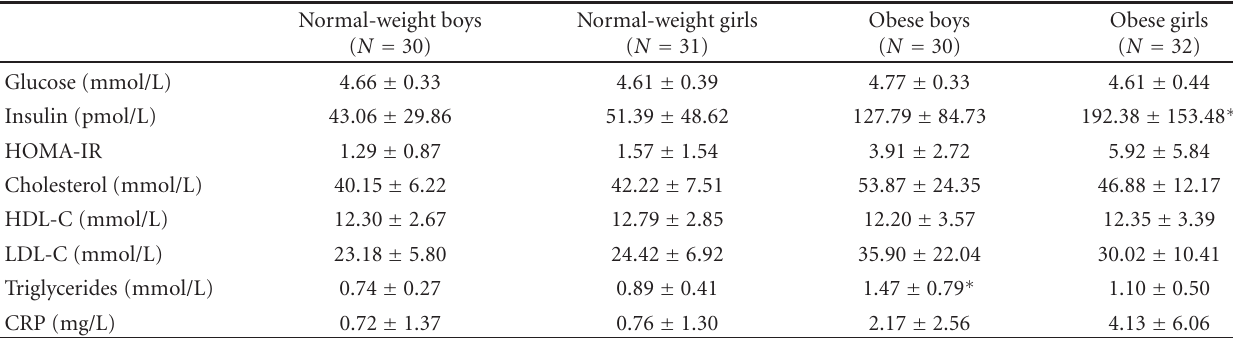
Table 2: Serum Measures.